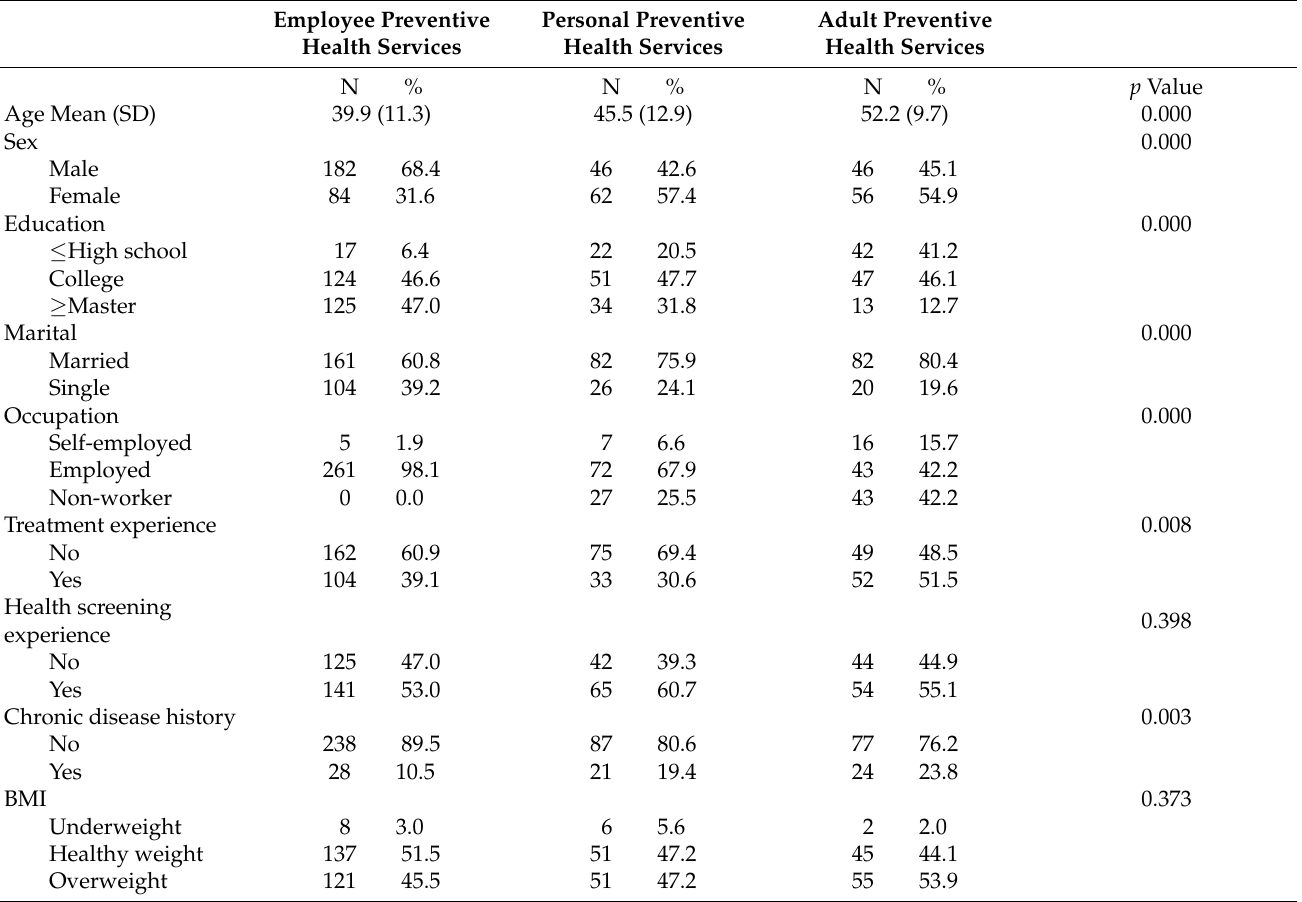
Table 1. Participant characteristics and comparative